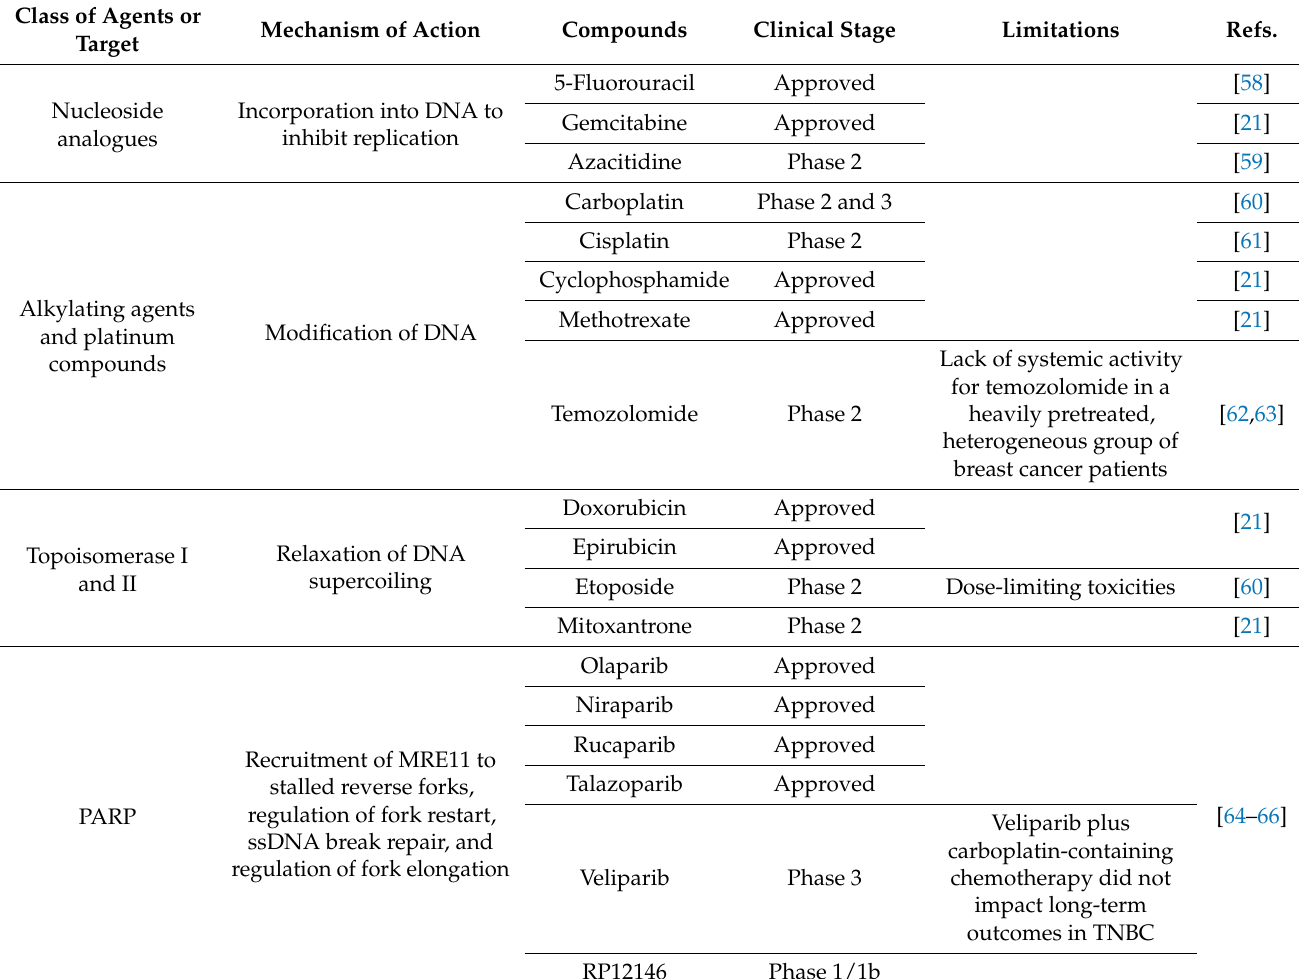
Table 1. Therapeutic agents that enhance replication stress in breast